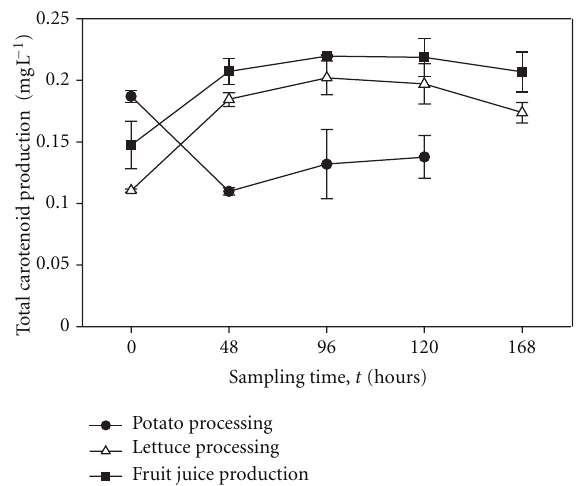
Figure 6: Total carotenoid production of R. glutinis during cultiva- tion on wastewaters from potato, lettuce, and fruit juice